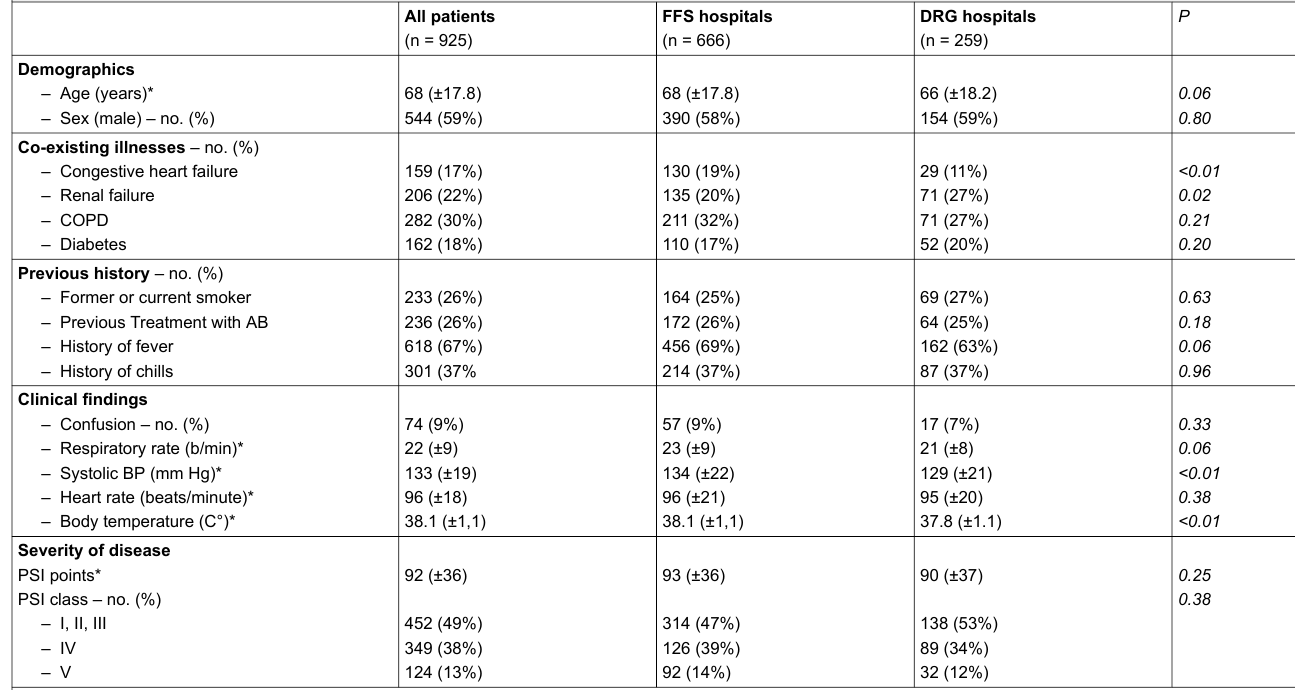
Table 1: Baseline characteristics of patients with community-acquired pneumonia according to hospital reimbursement system.